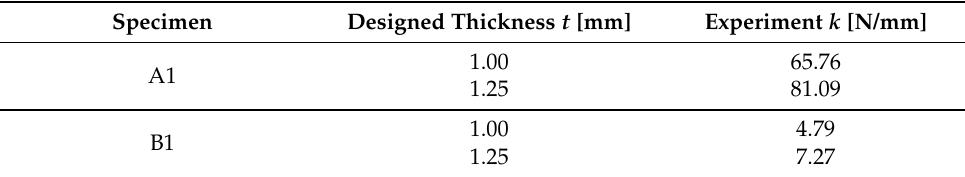
Table 5. Values of determined stiffness k from